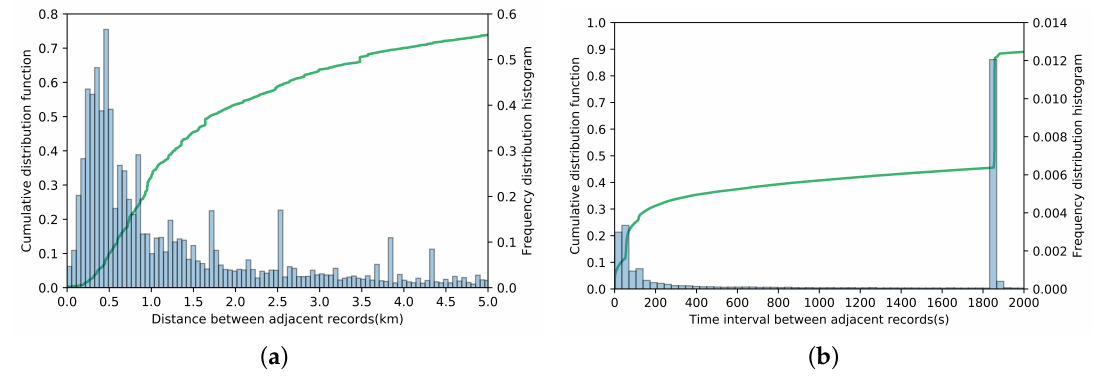
Figure 1. Distribution of the distance and time interval between adjacent records. ( a ) Distribution of the distance between adjacent records; ( b ) Distribution of the time interval between adjacent